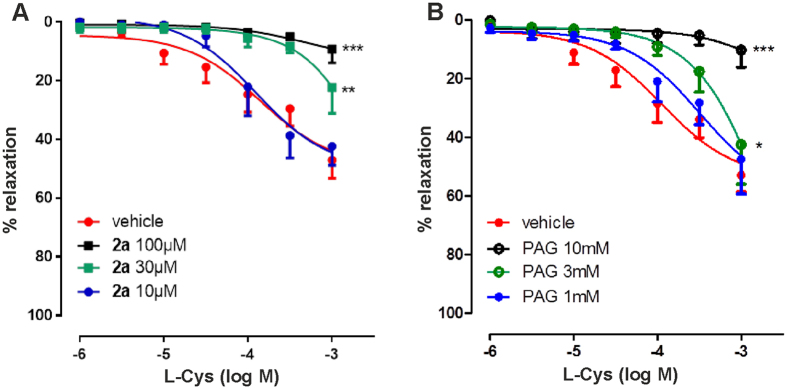
Measurement of L-Cys induced vasorelaxation.(A,B) The assay was repeated at the concentration at which 2a and PAG exert maximal inhibition. N = 6 rings harvested from 6 different animals for each group of experiments. Vehicle, water.